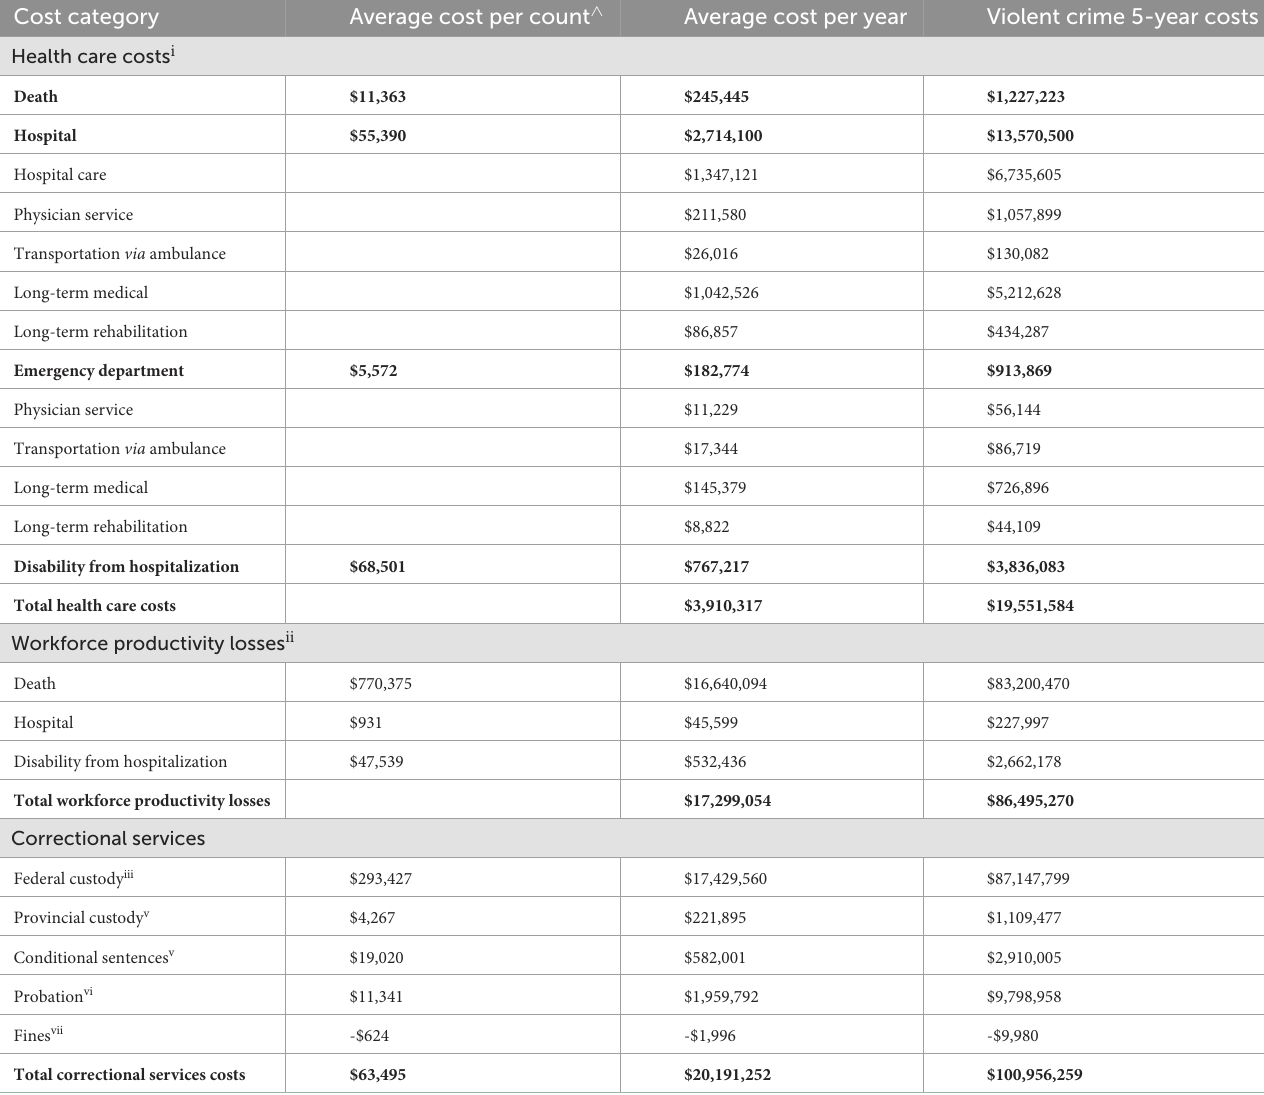
TABLE 5 Breakdown of average and total costs for health care, productivity losses and correctional services in 2016 CAN Dollars, B.C. 2012–2016. Cost